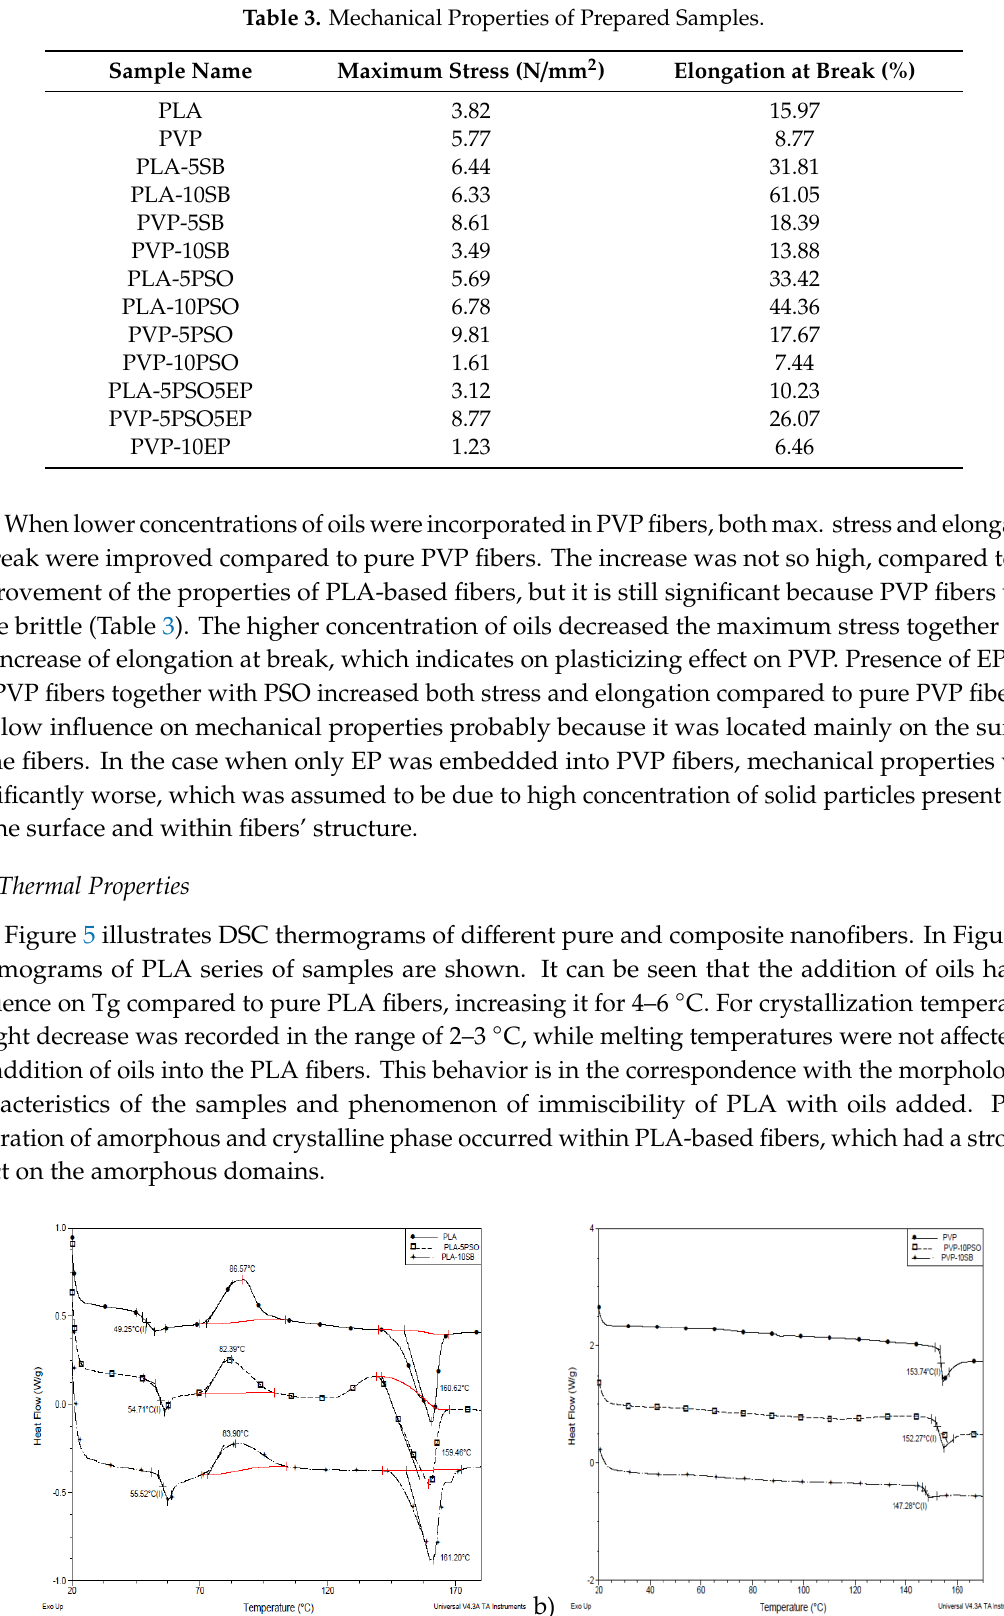
Table 3. Mechanical Properties of Prepared Samples.